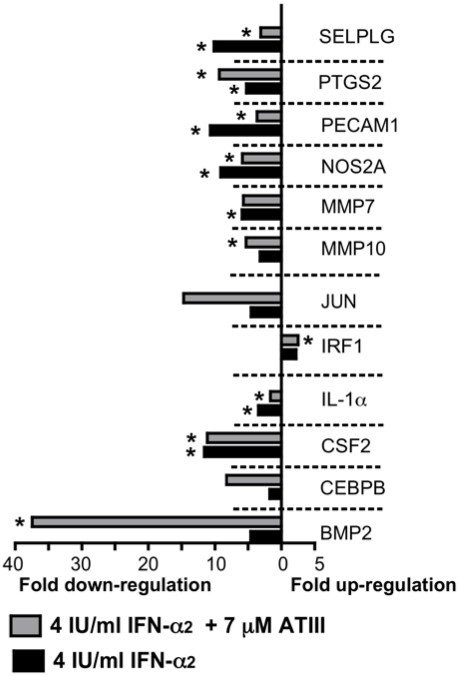
Down-regulation of key signal transduction pathway genes in HCV OR6 replicon after treatment with IFN-α and ATIII. 5x104 HCV OR6 replicon cells were treated with 7 μM ATIII/ml and 4 IU/ml IFN-α for 48 h, and RNA was purified. A real-time RT-PCR expression array was used to analyze the expression of 84 key genes from 18 signal transduction pathways. Genes with significant changes (*, P<0.05), in gene expression compared to vehicle control as calculated by the ΔΔCt method of three independent experiments are shown. All genes are normalized using the GAPDH house-keeping gene. Only genes with more than a 2-fold change in gene-expression are shown.